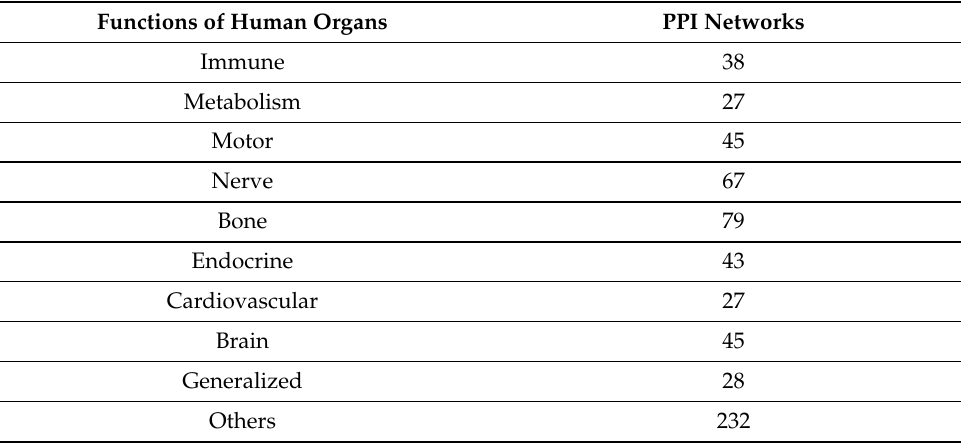
Table 1. Classification of PPI networks by functions of human